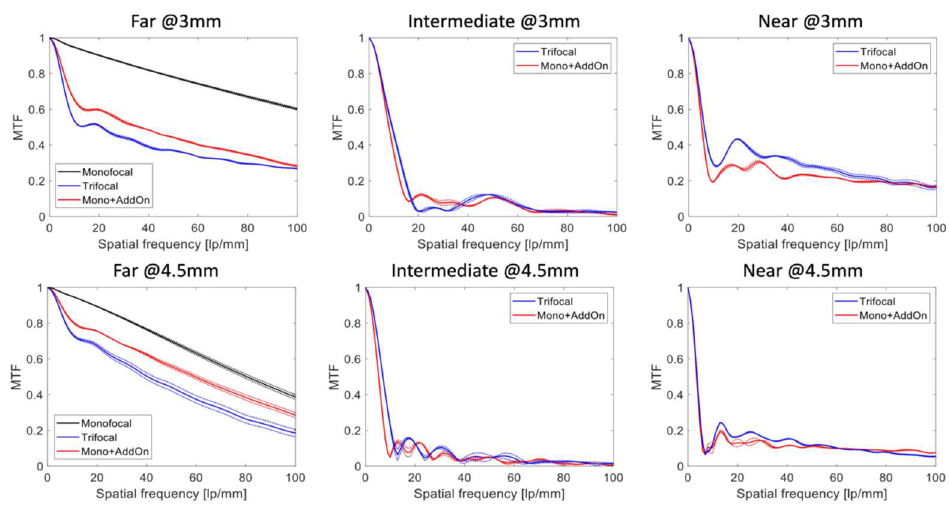
Figure 2. The modulation transfer function (MTF) of the monofocal, and single-lens trifocal and Mono-AddOn measured at a 3 and 4.5 mm pupil. The dotted lines show the values of each lens separately, the solid lines refer to the average of two IOLs.